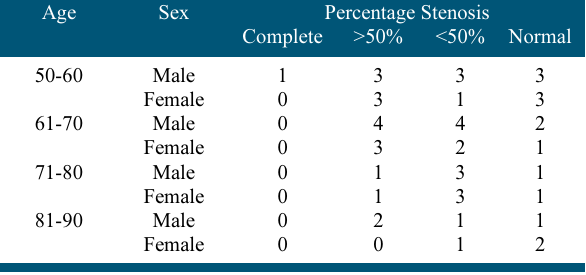
Figure 8: Non obstructing plaque in CCA Table 2: Distribution of patients with maximum stenosis with age and sex.